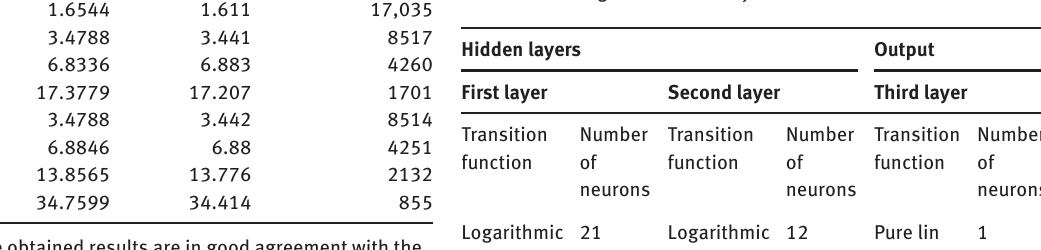
Table 3 Characteristics of the trained neural network used to model the strength of the four-layer